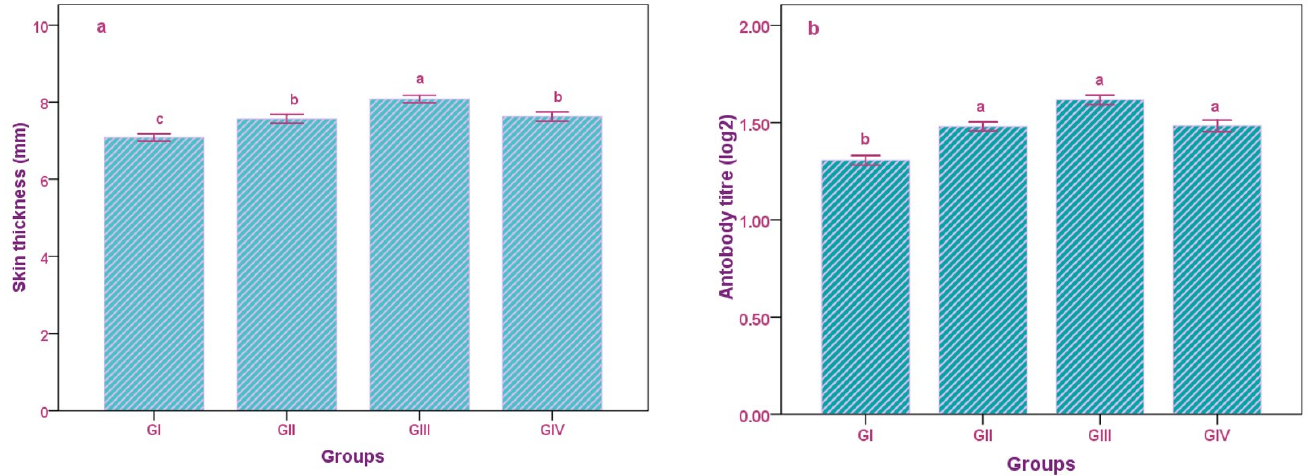
Figure 1. Impact of replacement of concentrate with Moringa oleifera leaves in different groups of goat kids on ( a ) cell-mediated immunity and ( b ) humoral immunity. Bars followed by different letters indicate that the mean ± SEM values showed significant differences ( p < 0.05).